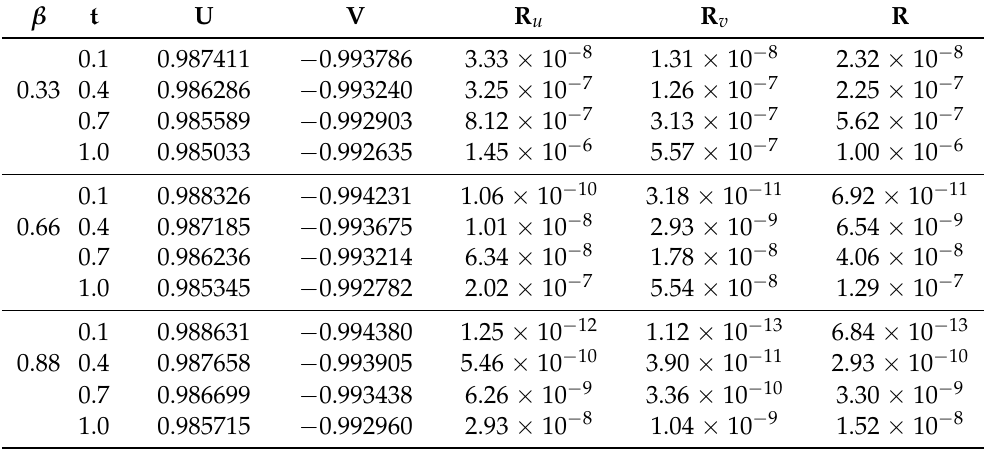
Table 4. LHPM solutions and errors at different values of β in Example 2 when x = 8 and η = a = 0.5 (where R u and R v represent residual errors in first and second equations, and R is the system